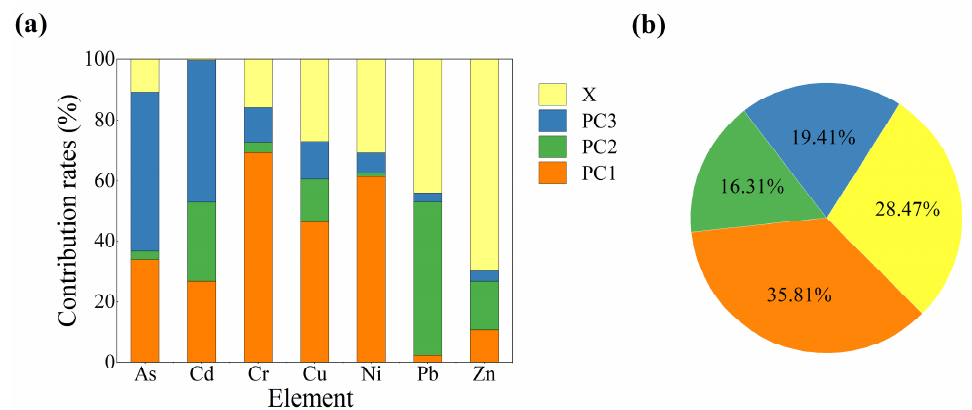
Figure 4. The contributions obtained from the APCS-MLR model: ( a ) Average contribution of each source to individual heavy metals in soils. ( b ) Average contribution of each source to all heavy metal content. (X represents unidentified sources).